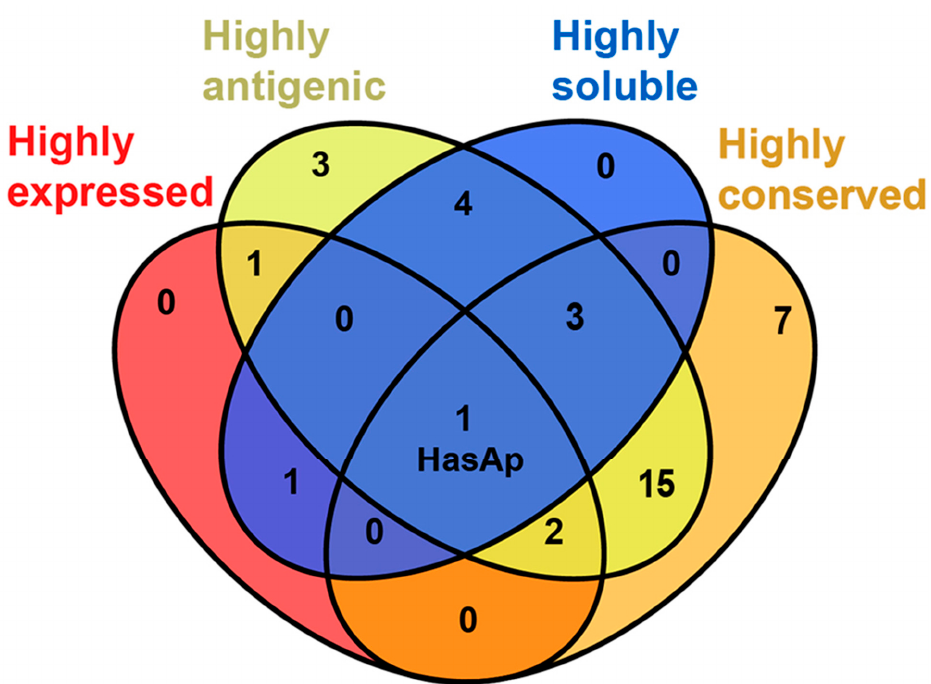
Figure 3. Venn diagram analysis showing that HasAp is shared between the four lists representing highly expressed, highly antigenic, highly soluble, and highly conserved IAPs.